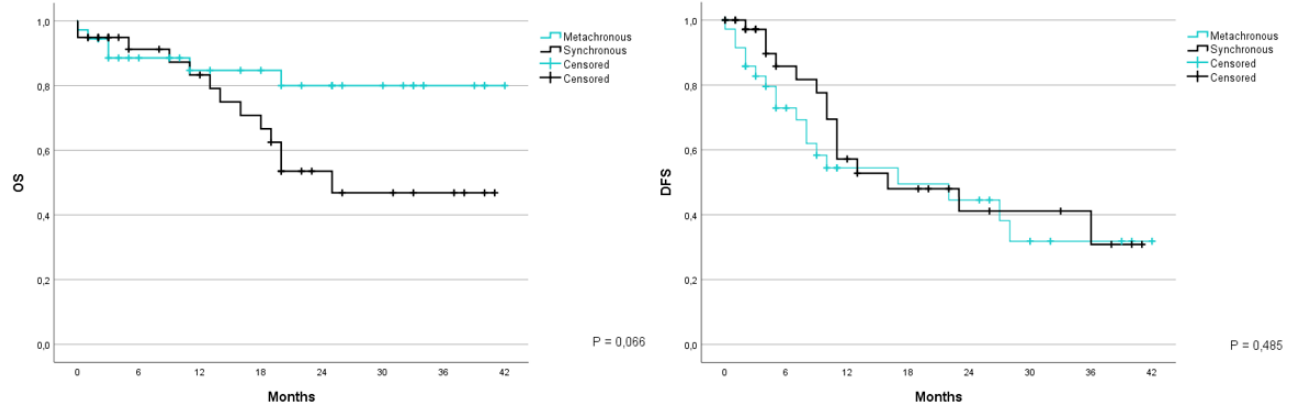
Figure 1. Kaplan-Meier curve for OS and DFS in patients who underwent liver resection for CRLM stratified based on the temporal presentation of metastasis (synchronous/metachronous). OS: overall survival; DFS: disease free survival; CRLM: colorectal liver metastases.